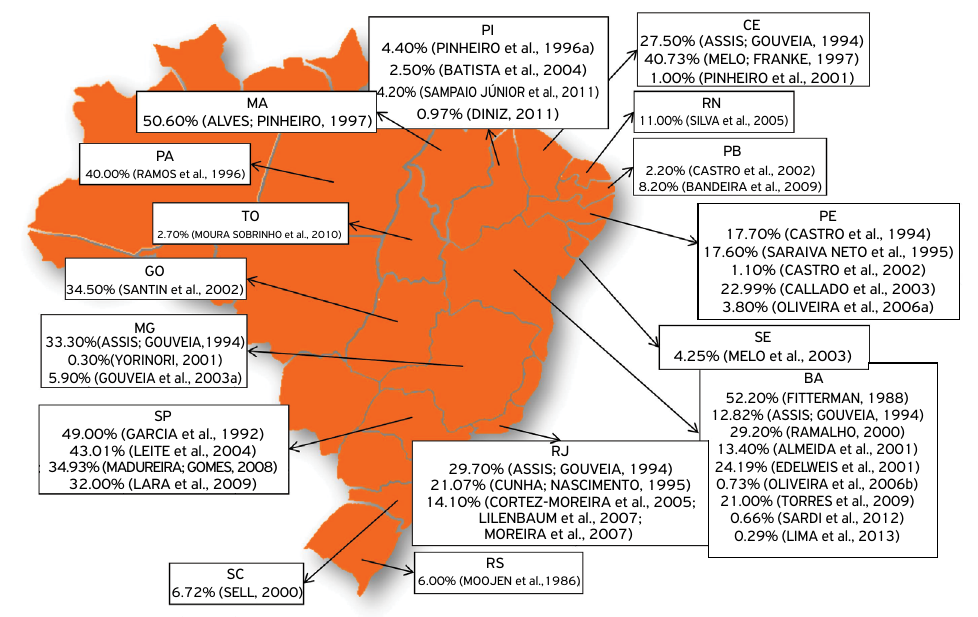
Figure 2. Seropositivity for lentiviruses of small ruminants in goats from different states in